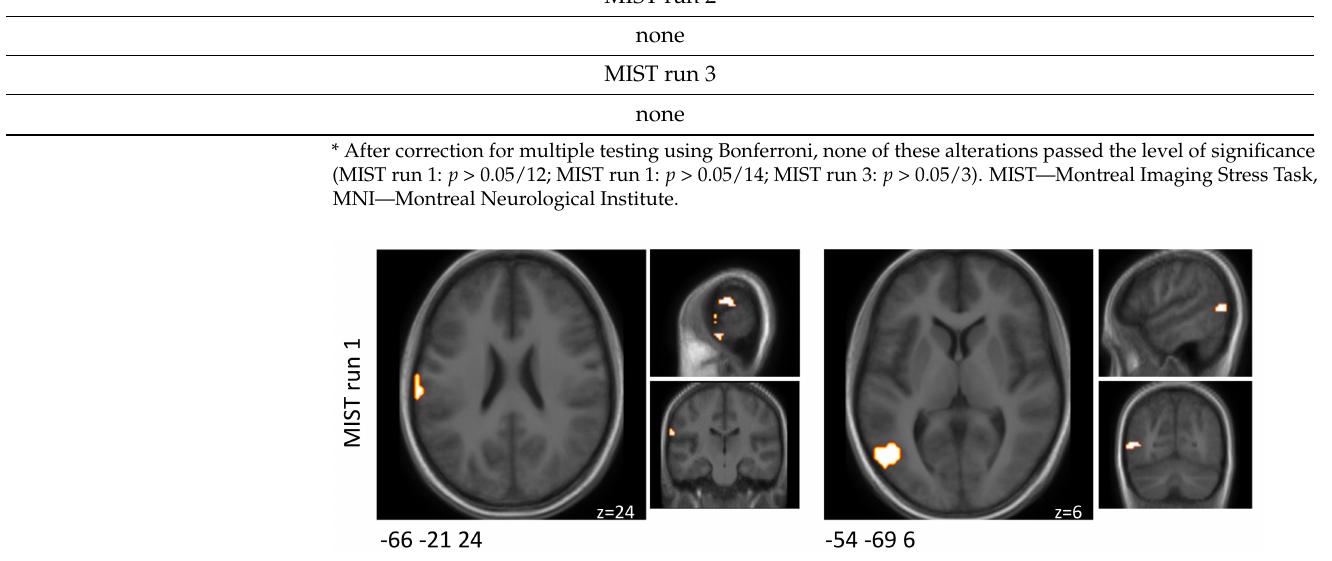
Figure 2. Schematic visualisation of clusters that were found to be associated with changes in brain activity ( p < 0.1) when comparing the probiotic and the placebo interventions (probiotic > placebo) and when comparing the experimental and control condition before multiplicity correction during the MIST paradigm. Clusters are superimposed on average anatomical scans. Clusters can be identified by the coordinates of their peak (x y